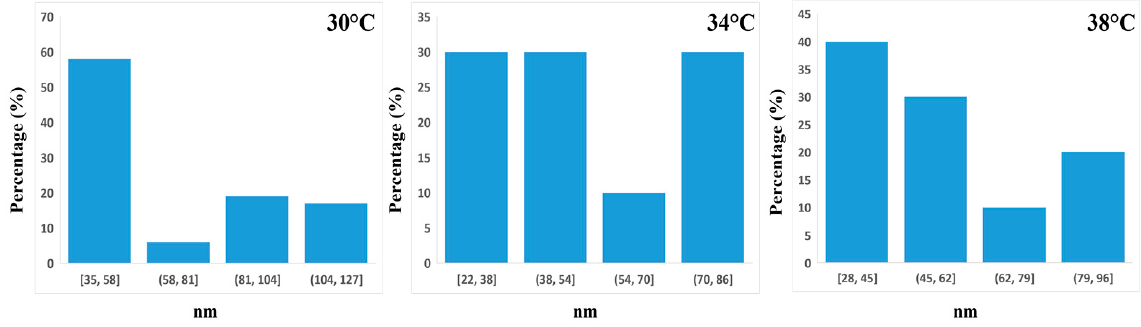
Figure 3. Histogram of size distributions of PNIPAM/magnetite NPs at various temperatures (0.25% PNIPAM solution).